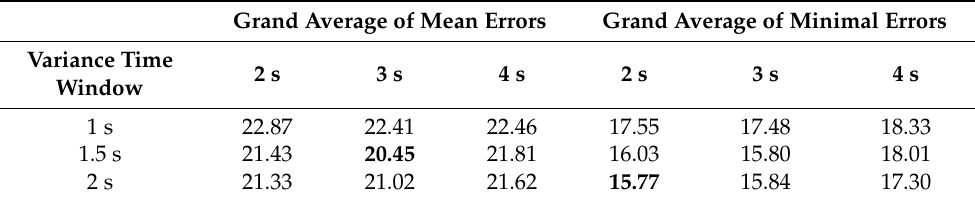
Table 2. Grand averages for mean and minimal errors presented in Table